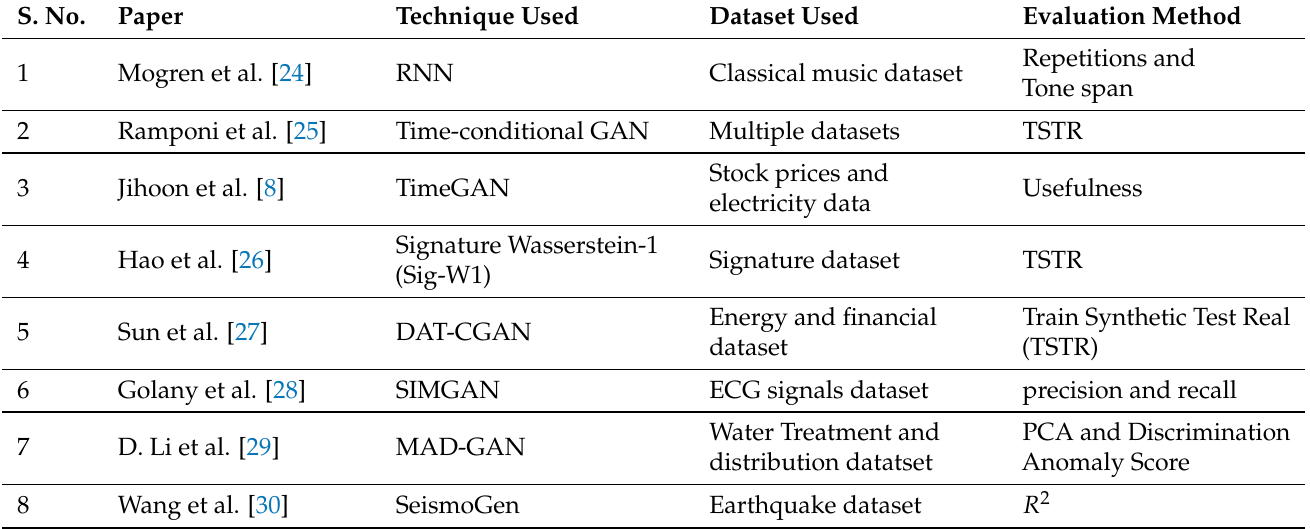
Table 1. Related Works: comparison